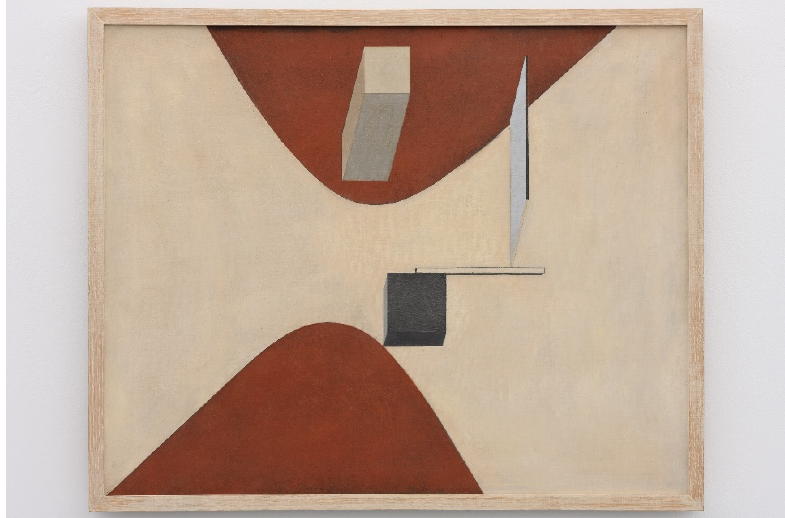
Figure 13. El Lissitzky, ‘Proun P23, no. 6’, 1919. Van Abbemuseum. Photo: Peter Cox.